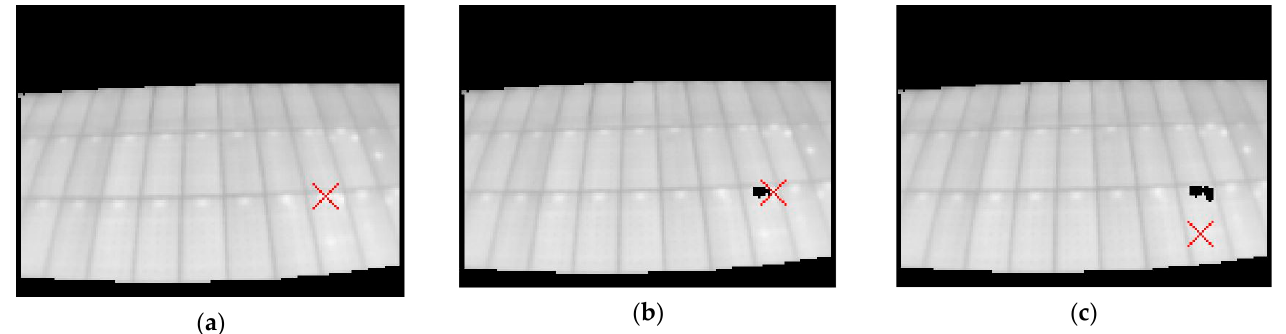
Figure 8. Visualization of the first three detected points. ( a ) First point; ( b ) Second point; ( c ) Third point.